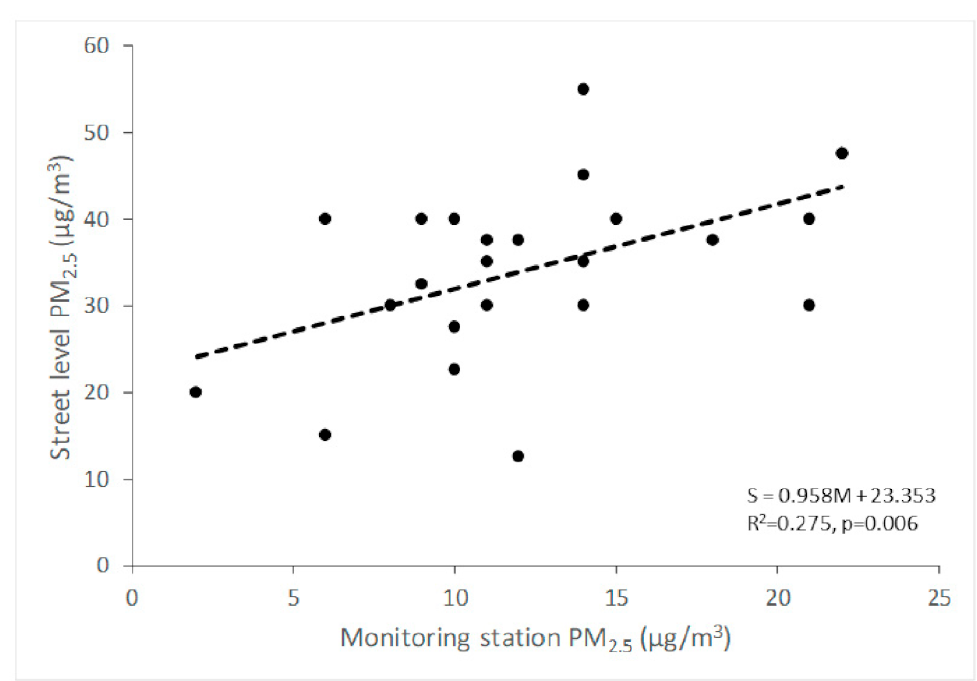
Figure 2. Correlation between PM 2.5 concentrations at the street level measured by the hand-held detector and those measured by the nearest monitoring